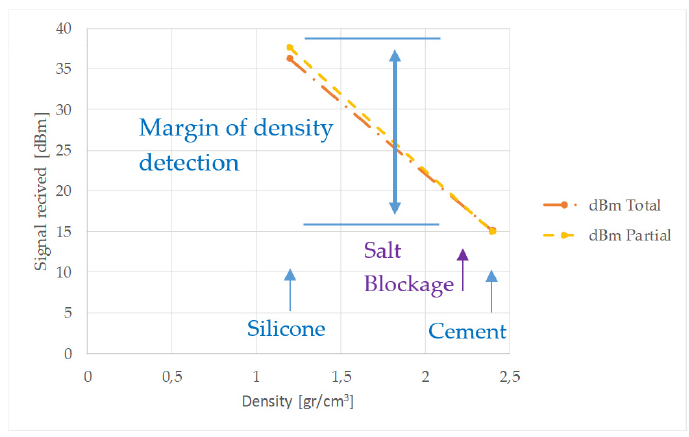
Figure 19. Transducer response versus material density with total and partial blockage (position B).